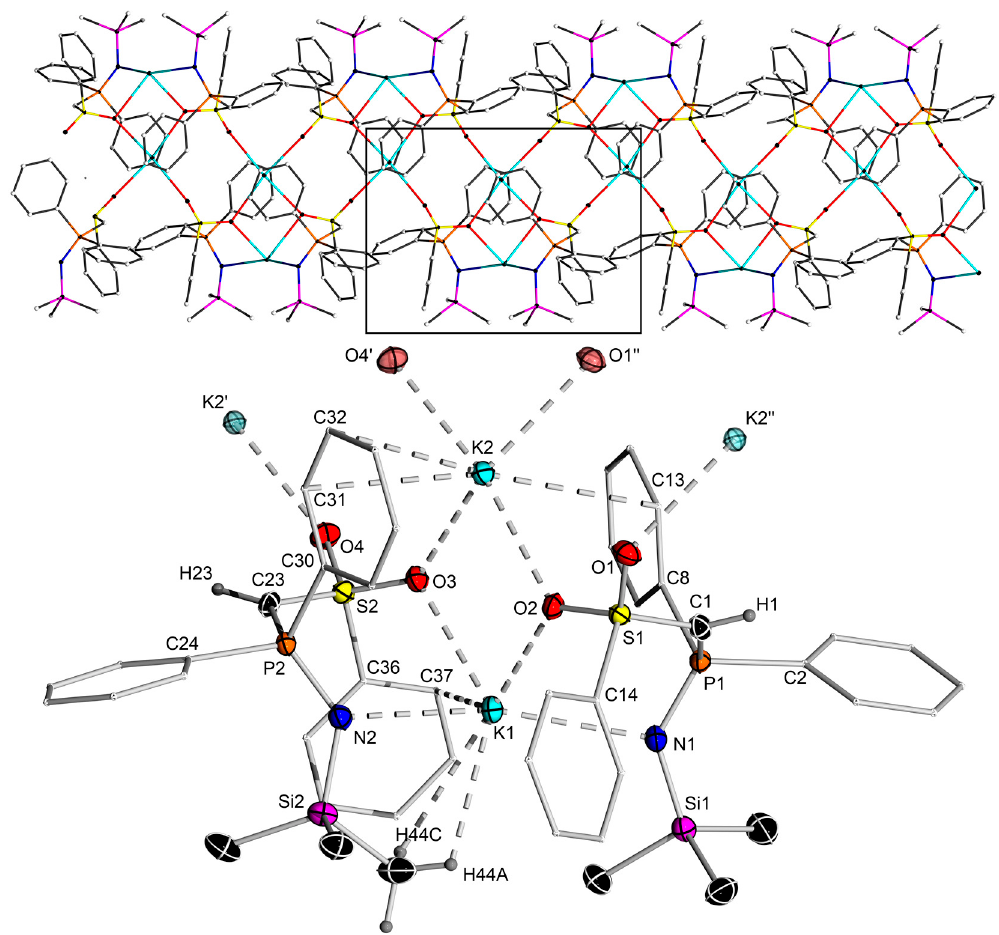
Figure 5. Polymeric structure of monometalated system 1-K ( top ); and highlighted asymmetric unit ( bottom ). Ellipsoids drawn at the 50% probability level. Hydrogen atoms (except for the methylene bridge) and solvent molecule omitted for clarity. Connecting atoms of neighboring asymmetric units shown for clarity. Selected bond lengths (Å) and angles (°): C1–P1 1728(3), C1–S1 1.637(3), P1–N1